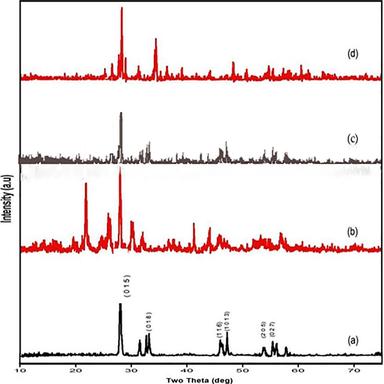
XRD patterns of synthezied Bi2Se3 nanostructures – a) Coprecipitation – without capping b) Coprecipitation – with capping c) Hydrothermal – without capping d) Hydrothermal – with capping.